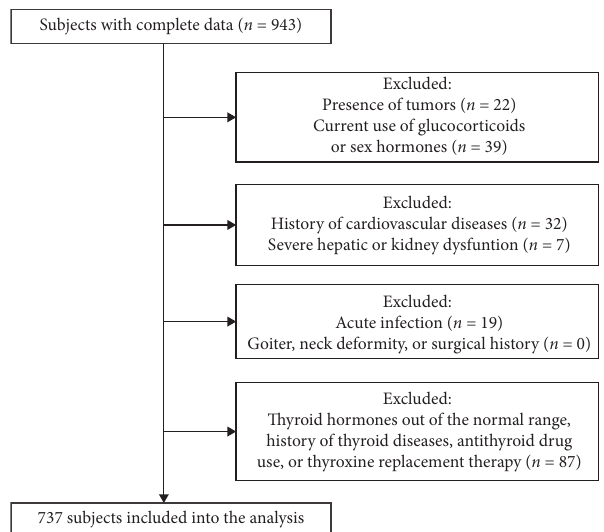
Figure 1: Flowchart of the study